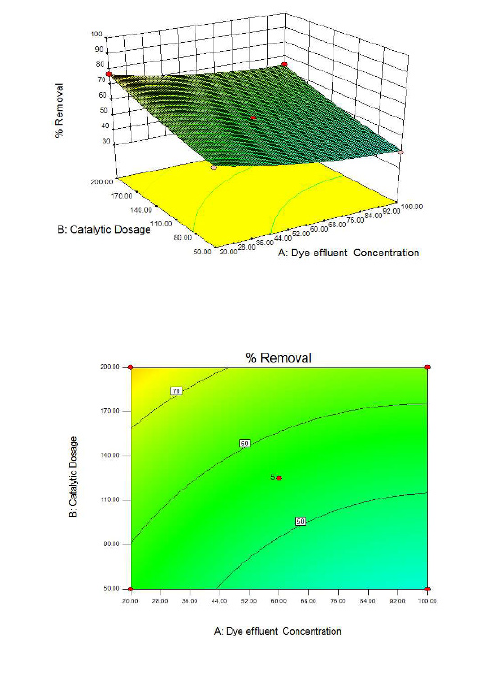
Figure 3. 3D Response surface (Top) and contour plots (Bottom) showing the interaction between Dye effluent concentra- tion and catalytic dosage for solar induced photocatalytic decolourization of dye effluent (at pH 7; Irradiation Time 60 min).